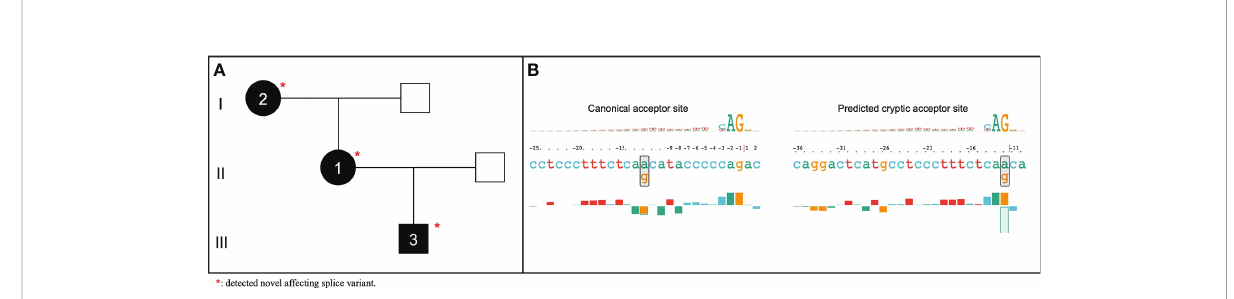
FIGURE 4 Pedigree of HAE affected family without previously reported causal variant (A) and representation generated by SQUIRLs of predicted acceptor site for the novel SERPING1 c.686-12A>G affecting splice variant (B) .